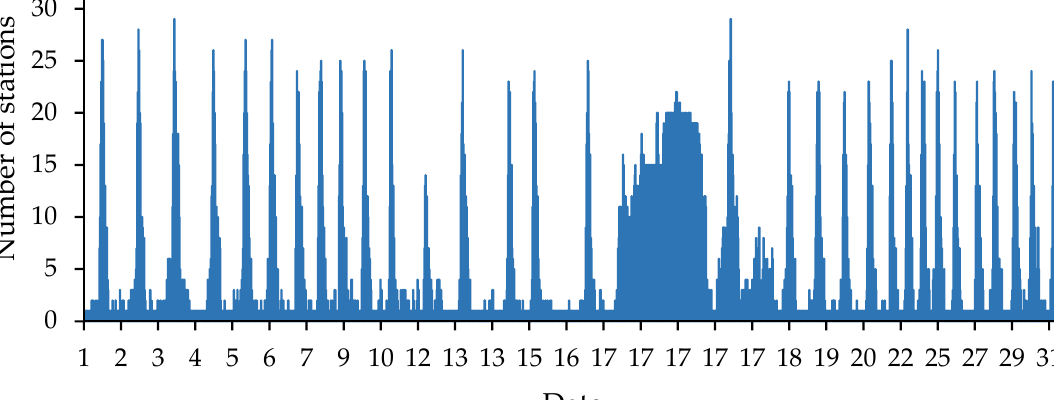
Figure 7. Plot of the distribution of simultaneously occurred discrepancies in March 2015. The plot of solution discrepancies in Figure 8 shows that the discrepancies in the Up component of RIGA station reached − 531.42 m at 17:09:00 UT.